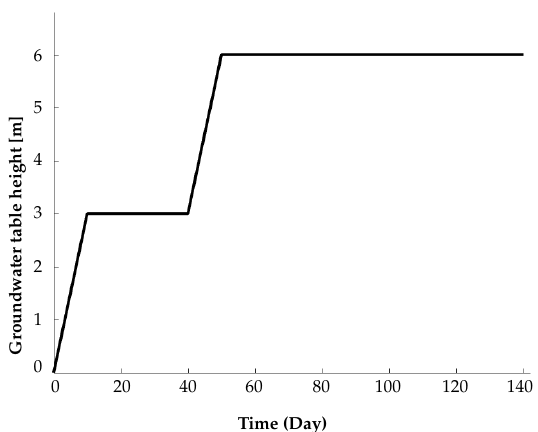
Figure 3. Numerical simulation of the change in the groundwater level on the left side of the vadose